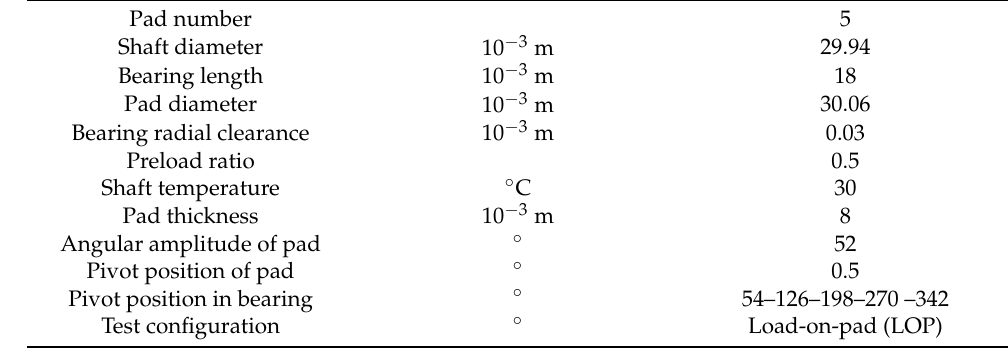
Figure 17. Flowchart of the identification procedure. Table 1. Geometrical characteristics of the TPJB.